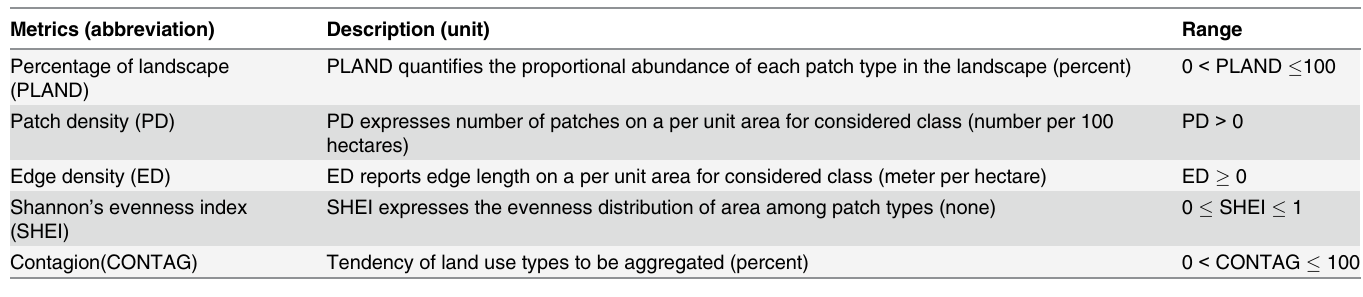
Table 1. List of the selected landscape